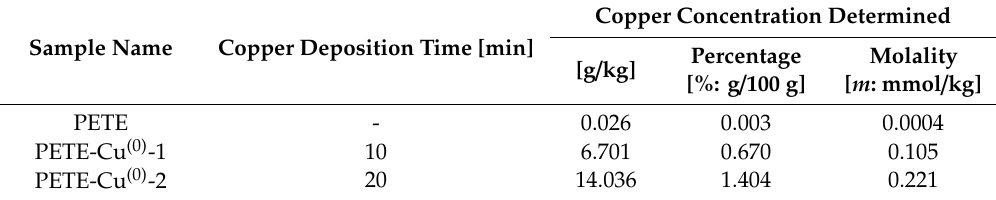
Table 2. Results of determination of copper content in PETE and PETE-Cu (0) composite samples by Flame Atomic Absorption Spectrometry